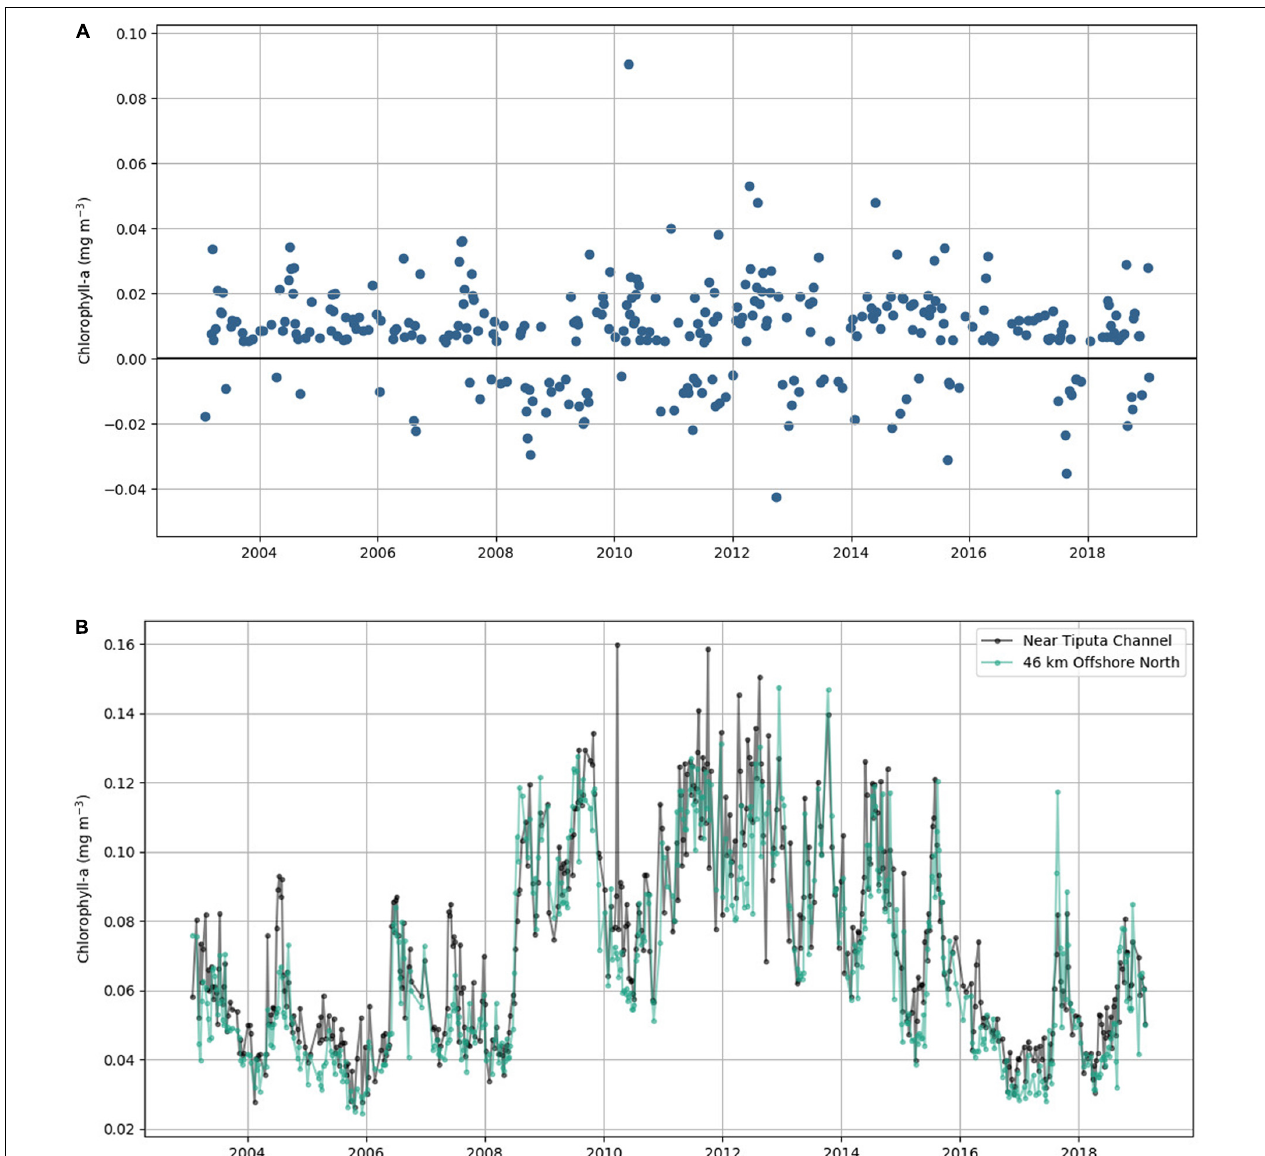
FIGURE 2 | (A) Eight-day average of chlorophyll-a difference between near Tiputa Channel and offshore from January 2003 to February 2019. Positive values represent times when the IME was present; negative values represent times when the IME was not present. (B) Eight-day average of chlorophyll-a data near Tiputa Channel (black) and offshore (aqua).